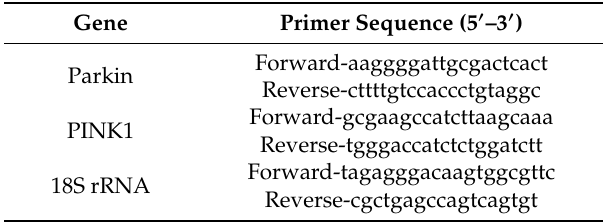
Table 1. Oligonucleotide sequences used in qRT-PCR analysis. Gene Primer Sequence (5 (cid:48) –3 (cid:48)